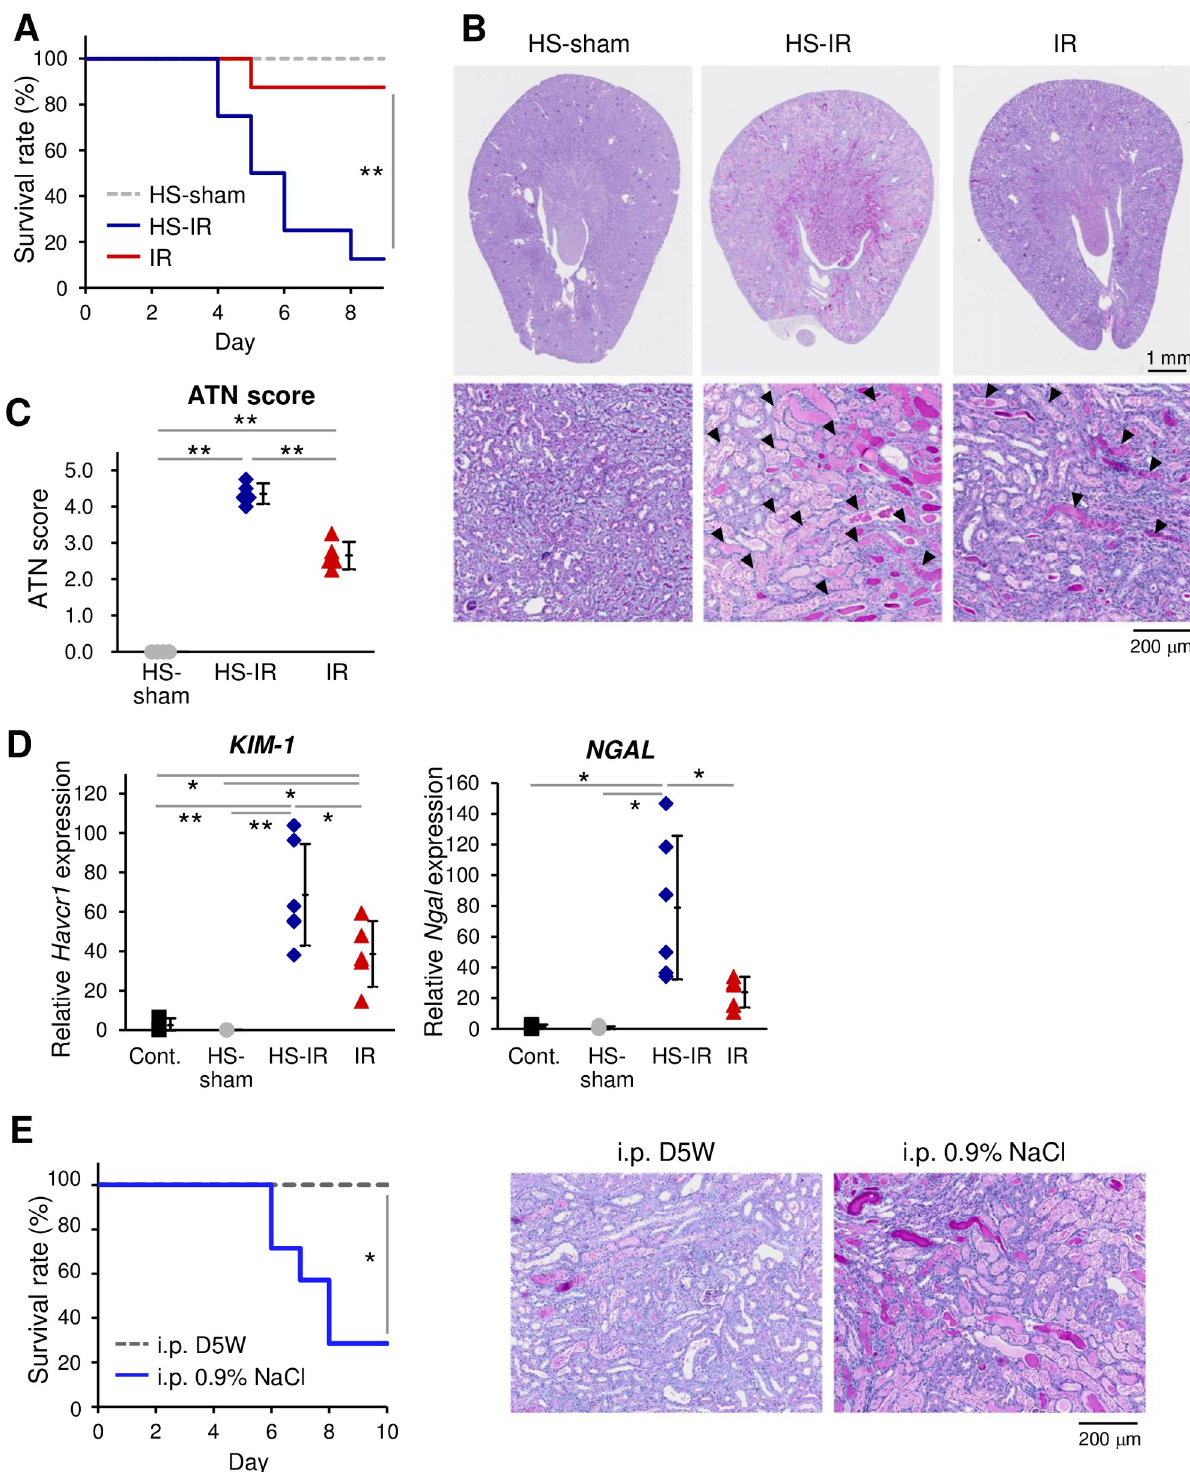
Fig 1. Detrimental effect of high salt on IR-induced AKI. (A) Survival curves. Kaplan-Meier survival curves of wild-type AKI mice with (HS-IR) or without (IR) HS ( n = 8 per group). The significance of differences between HS-IR and IR was calculated with the log-rank test. Sham-treated mice (without IR) fed an HS diet were also analyzed (HS-sham, n = 4). (B) Representative PAS-stained histological images . Presented images are of the whole kidney and corticomedullary junction area from HS-sham ( n = 4) and IR mice with (HS-IR) or without (IR) HS ( n = 5 per group) on day 3